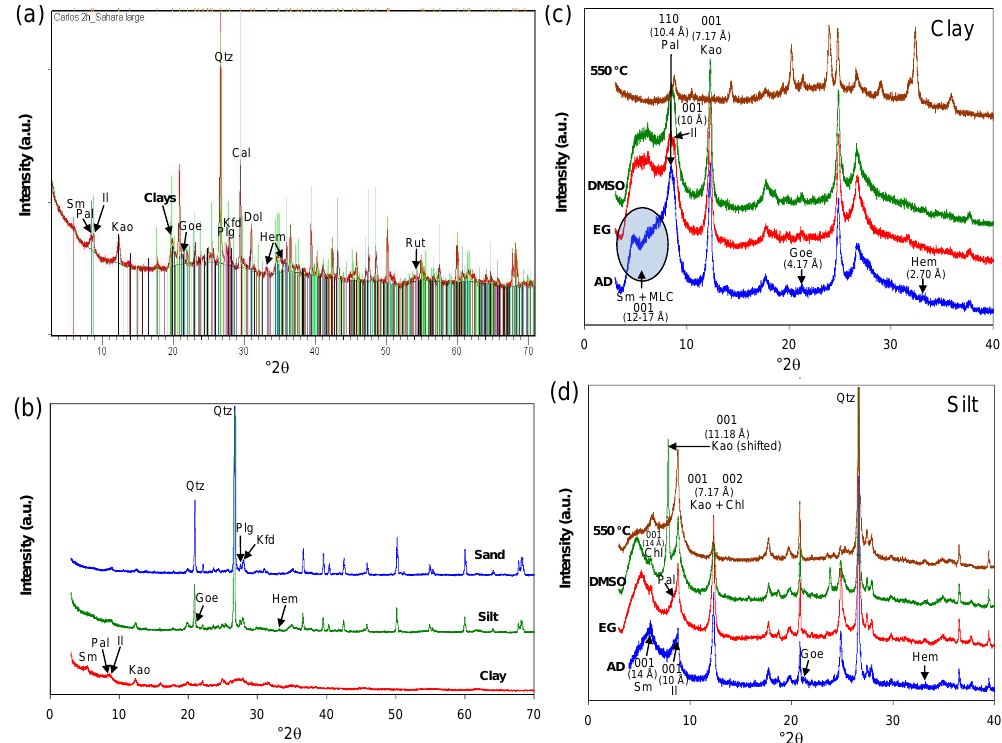
Figure 5. XRD analysis of Saharan dust: (a) XRD pattern of the bulk sample showing the presence of smectites (Sm), palygorskite (Pal), illite (Il), kaolinite (Kao), goethite (Goe), quartz (Qtz), K-feldspar (Kfd), plagioclase (Plg), calcite (Cal), dolomite (Dol), rutile (Rut), and hematite (Hem). The general reflection of clay minerals (Clays) at 4.49Å is also indicated. Vertical color lines show the peak position of the different phases (only the main peaks corresponding to each phase are labeled). (b) XRD patterns of the sand, silt, and clay fractions (decarbonated). (c, d) XRD patterns of oriented aggregates of the clay and silt fractions, respectively (with different treatments). The hkl index and d -spacing (in Å) of the clay minerals’ main reflections are indicated in (c, d) . Chl: chlorite; MLC: mixed-layer